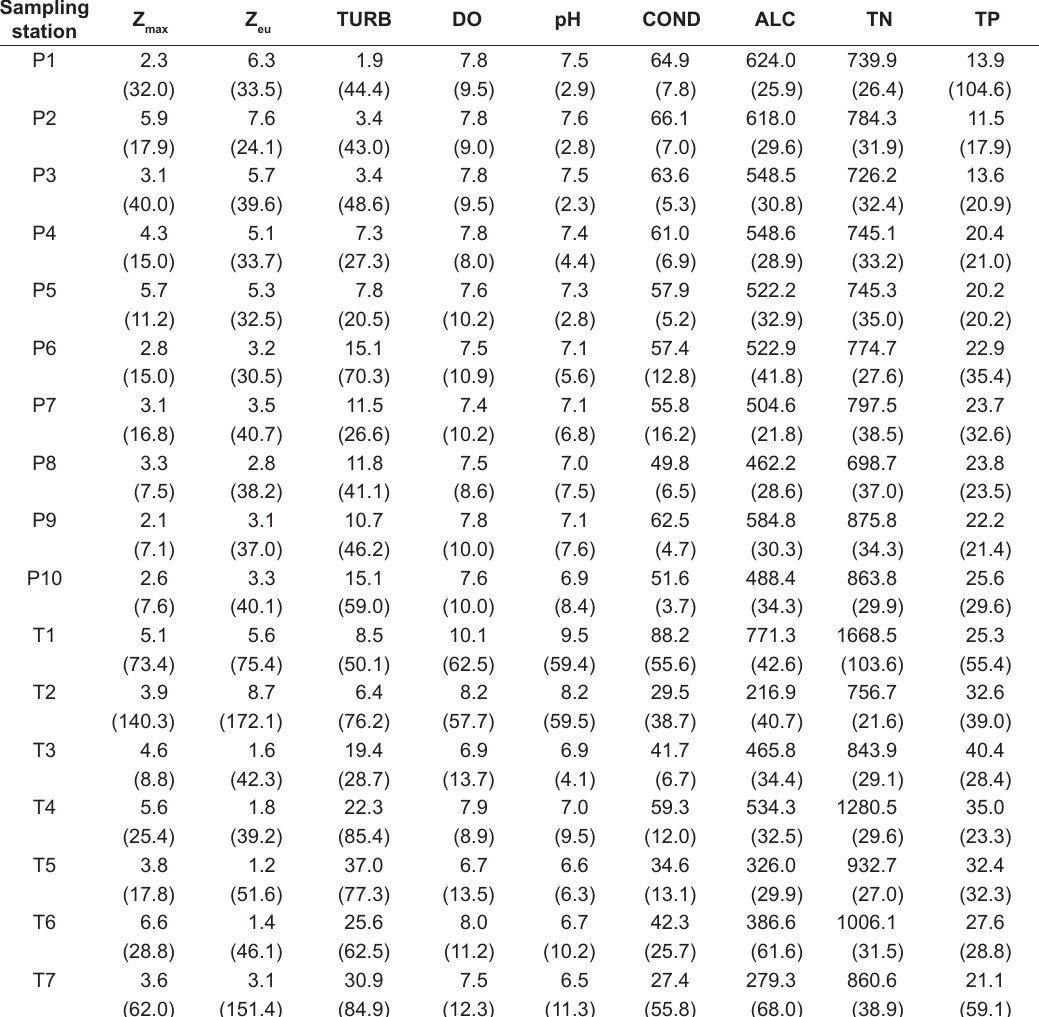
Table 2. Mean values and coefficient of variation (% in parentheses) of abiotic variables measured in the Paraná River main channel and in its main tributaries from August 2013 to May